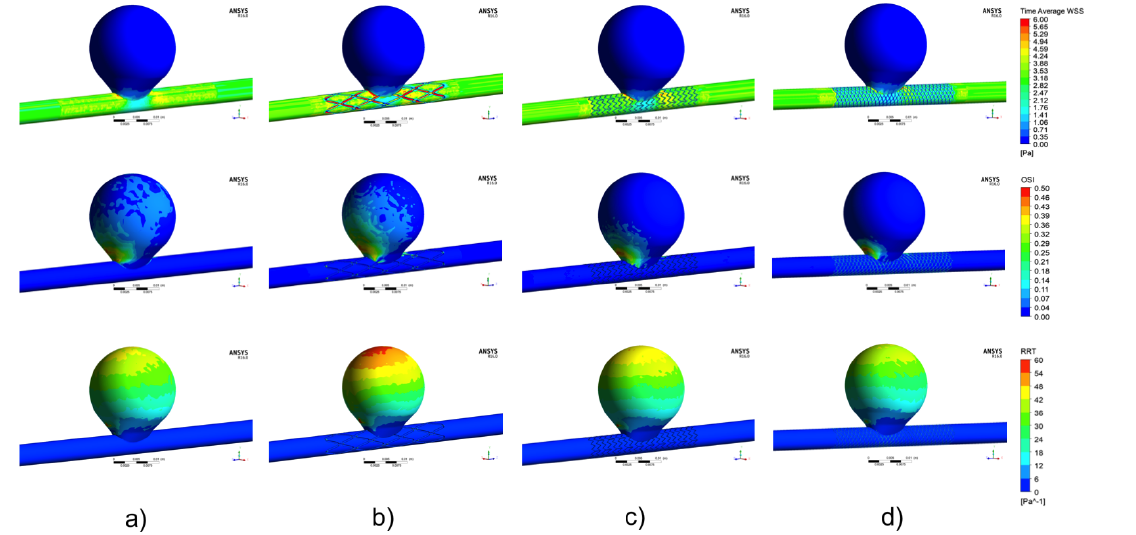
Figure 6. First row are the spatial distribution of the TAWSS, second row are the spatial distribution of the OSI, and third row are the spatial distribution of the RRT; for the cases of ( a ) control case, ( b ) STENT BS, ( c ) STENT 1, and ( d ) STENT